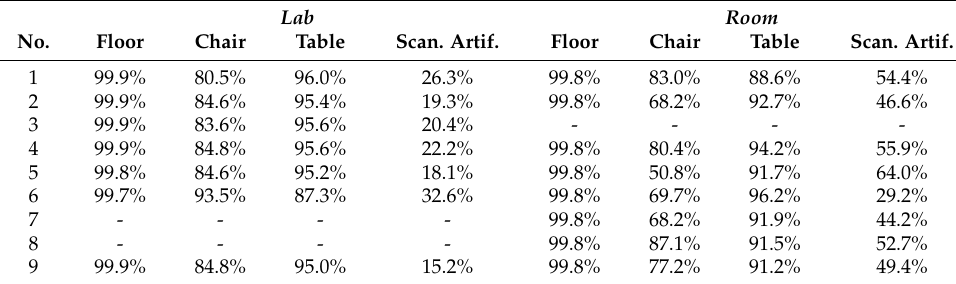
Table A7. Recall for the datasets Lab and Room , semantically segmented by PCCTRGB